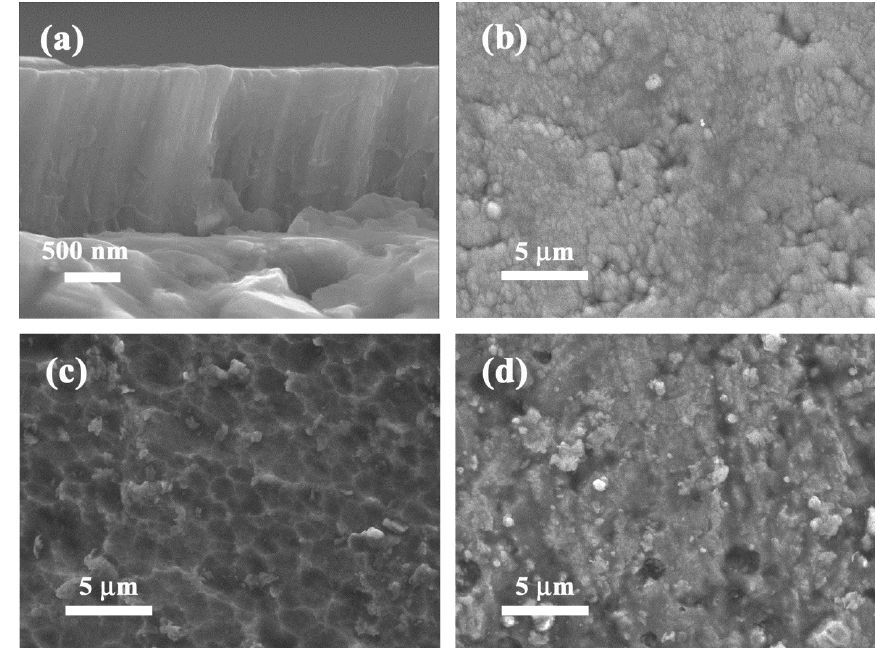
Figure 5. SEM micrographs of ( a ) cross-sectional and ( b ) surface structures of (Al 0.34 Cr 0.22 Nb 0.11 Si 0.11 Ti 0.22 ) 50 N 50 coatings; ( c ) surface structures of TiN coatings; and ( d ) surface structures of TiAlN coatings.